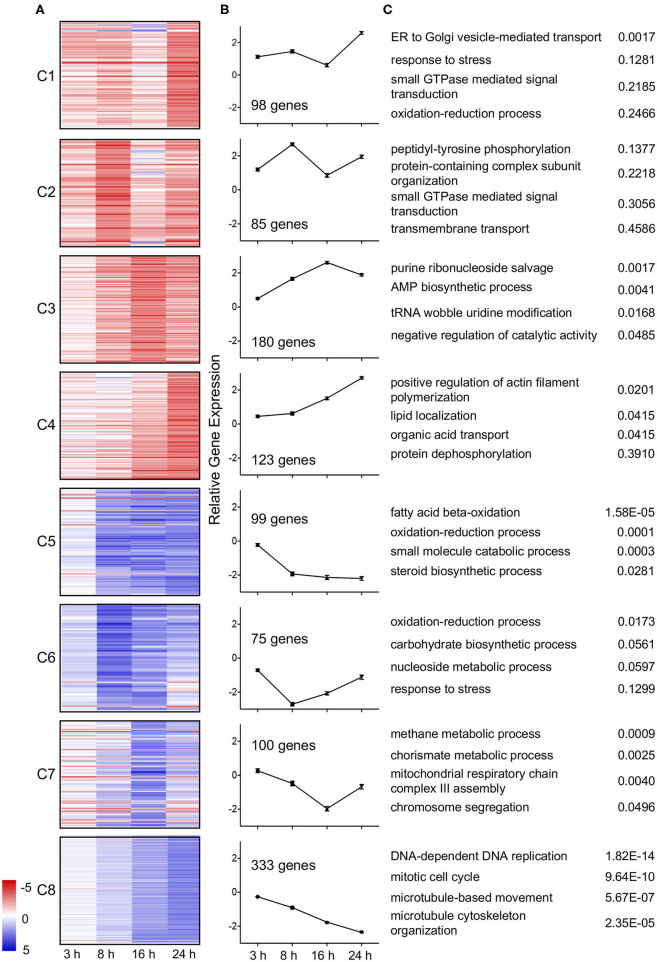
Temporal clustering of differential expressed genes of wild type L. pneumophila infected A. castellanii compared to ΔdotA infected A. castellanii. Eight temporal gene expression clusters based on k-means clustering of genes that were significantly differentially expressed between wild type L. pneumophila vs. ΔdotA mutant infected A. castellanii for at least one timepoint (fold-change of >4 or <1/4, PADJ < 0.05). (A) Heatmaps showing the log2 fold change in expression [blue (−5)—red (+5)] of the individual genes in cluster C1-C8. (B) Mean differential expression over time (C) GO enriched biological processes for each cluster and uncorrected p-value.